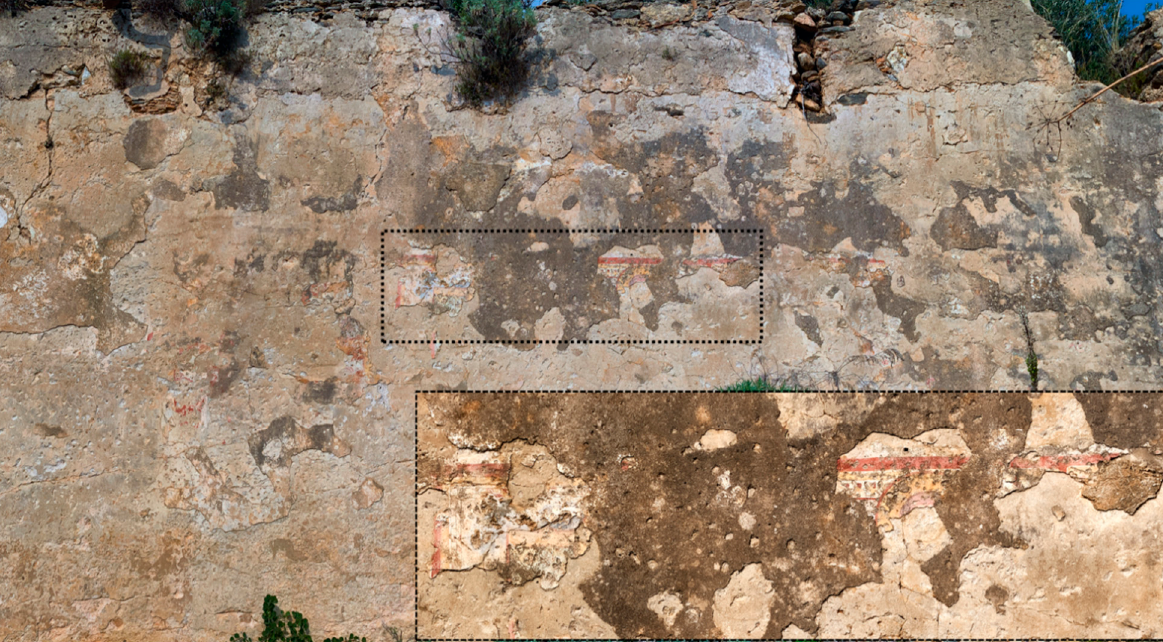
Figure 7. Nadiral aerial view of the church of San Basilio.